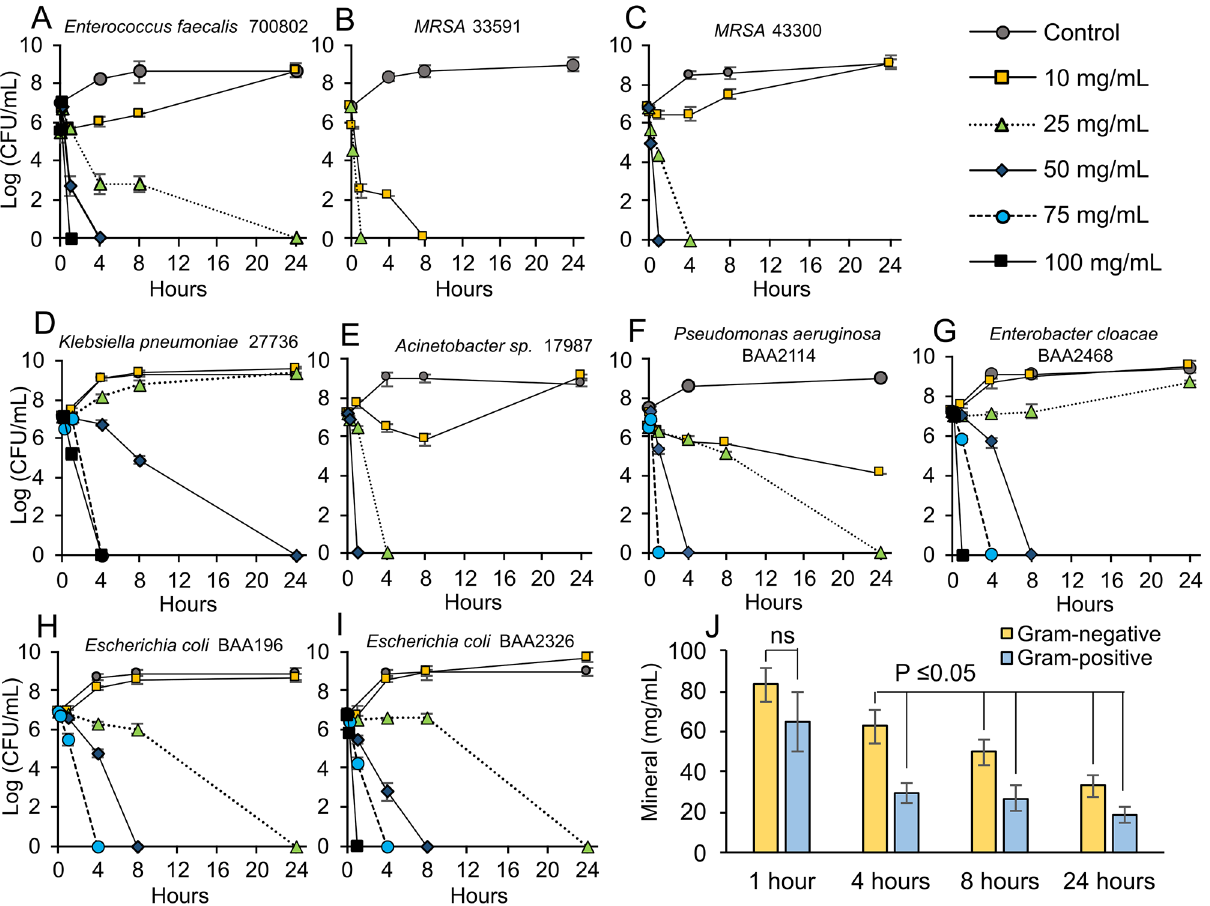
Figure 3. Antibacterial susceptibility testing of the multi-drug resistant ESKAPE pathogens. All experiments were performed with a mineral mixture containing 95 wt.% smectite and 5% pyrite, exchanged with 30 mM FeSO 4 . (A–I) Antibacterial susceptibility testing of antibiotic resistant ESKAPE pathogens to determine the dose response (10–100 mg/mL) where antibacterial activity occurs over 24 h. (J) Average MBC dose for Gram- negative or positive pathogens measured over 24